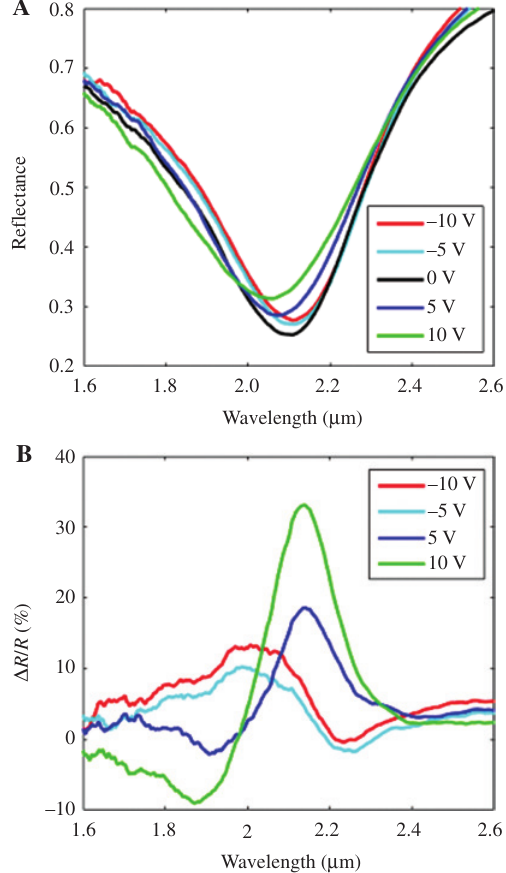
Figure 8: The experimental demonstration of the active tuning for device D1 (P = 1.0 μ m, W = 300